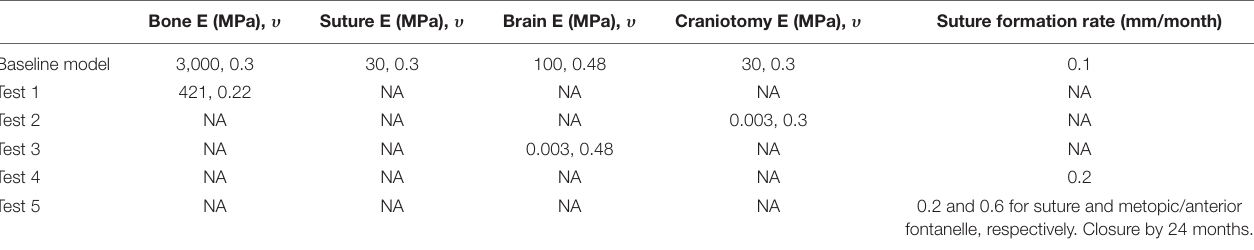
TABLE 1 | Material property and bone formation rate sensitivity summary.